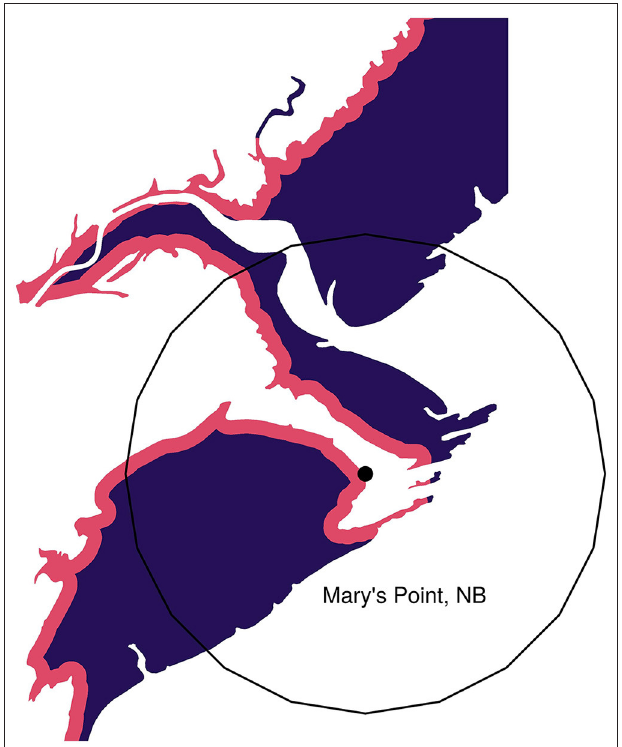
FIGURE 4 | Example showing the safe (purple) and dangerous (red) portions of a habitat. Mary’s Point, NB is shown with its geographic location highlighted by the point. The 2,500 m radius habitat circle is shown around this point. Only intertidal mudflat habitat is shown.